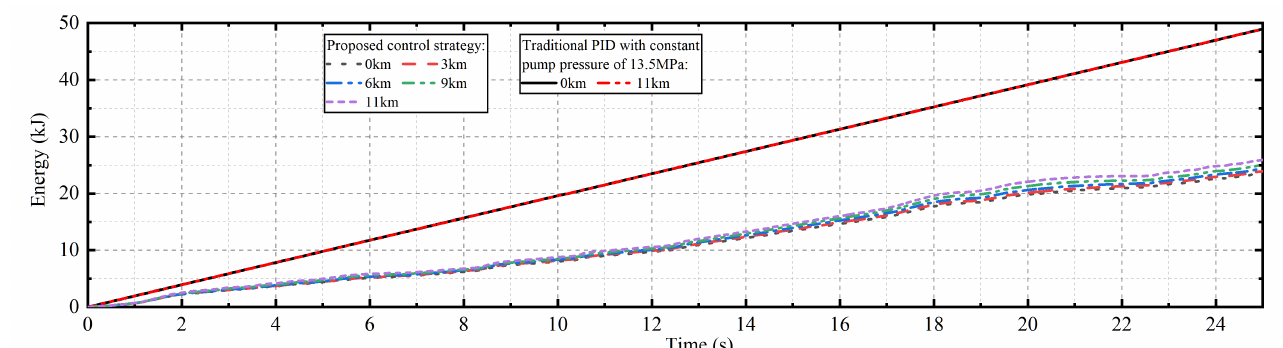
Figure 17. Tracking error of complex movement.